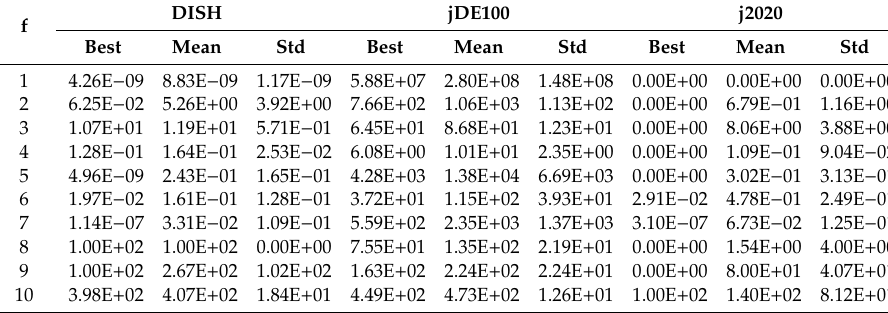
Table 20. DISH and jDE100 on CEC2020 in 10 D